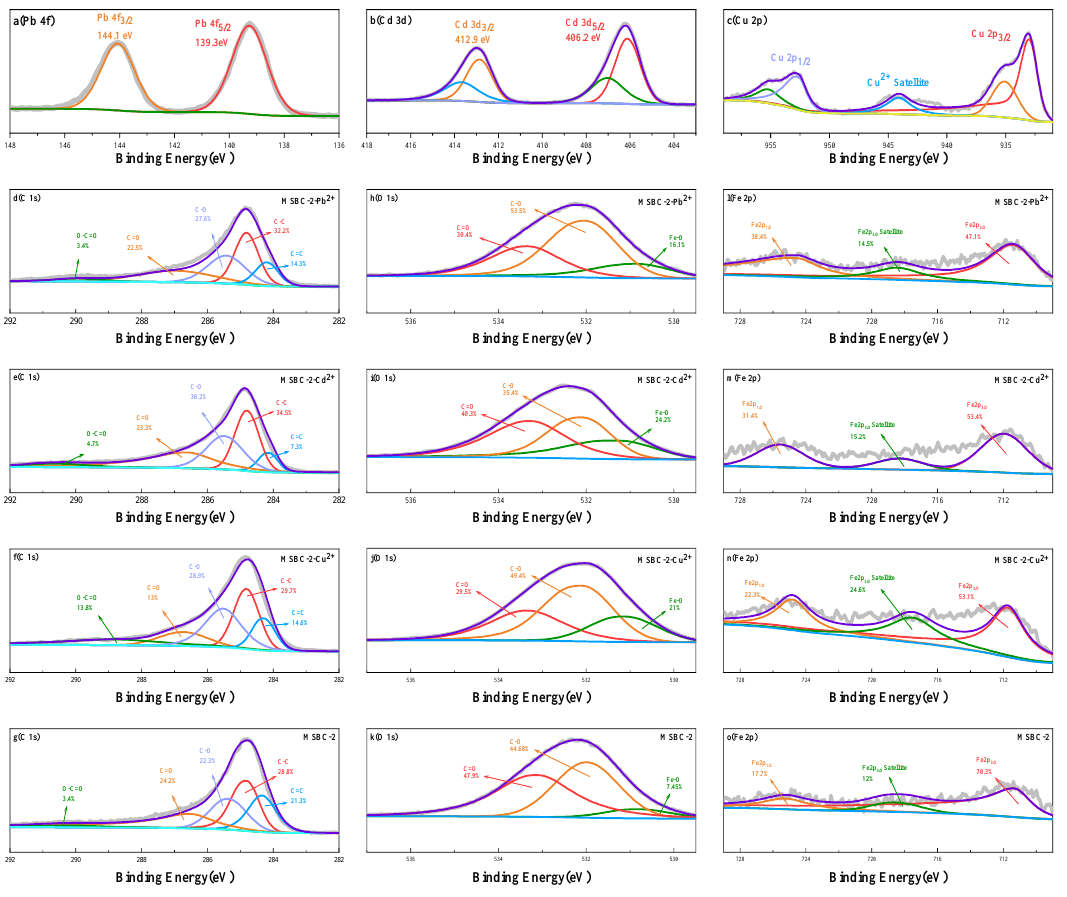
Figure 6. XPS analysis of MSBC-2 before and after Cd 2+ , Pb 2+ and Cu 2+ adsorption.